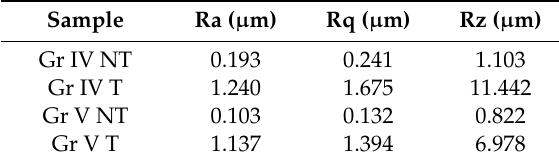
Table 4. Roughness parameters of the original samples (GR IV: Titanium grade IV; GR V: Titanium grade V; T: SLA treated; NT: SLA non-treated).